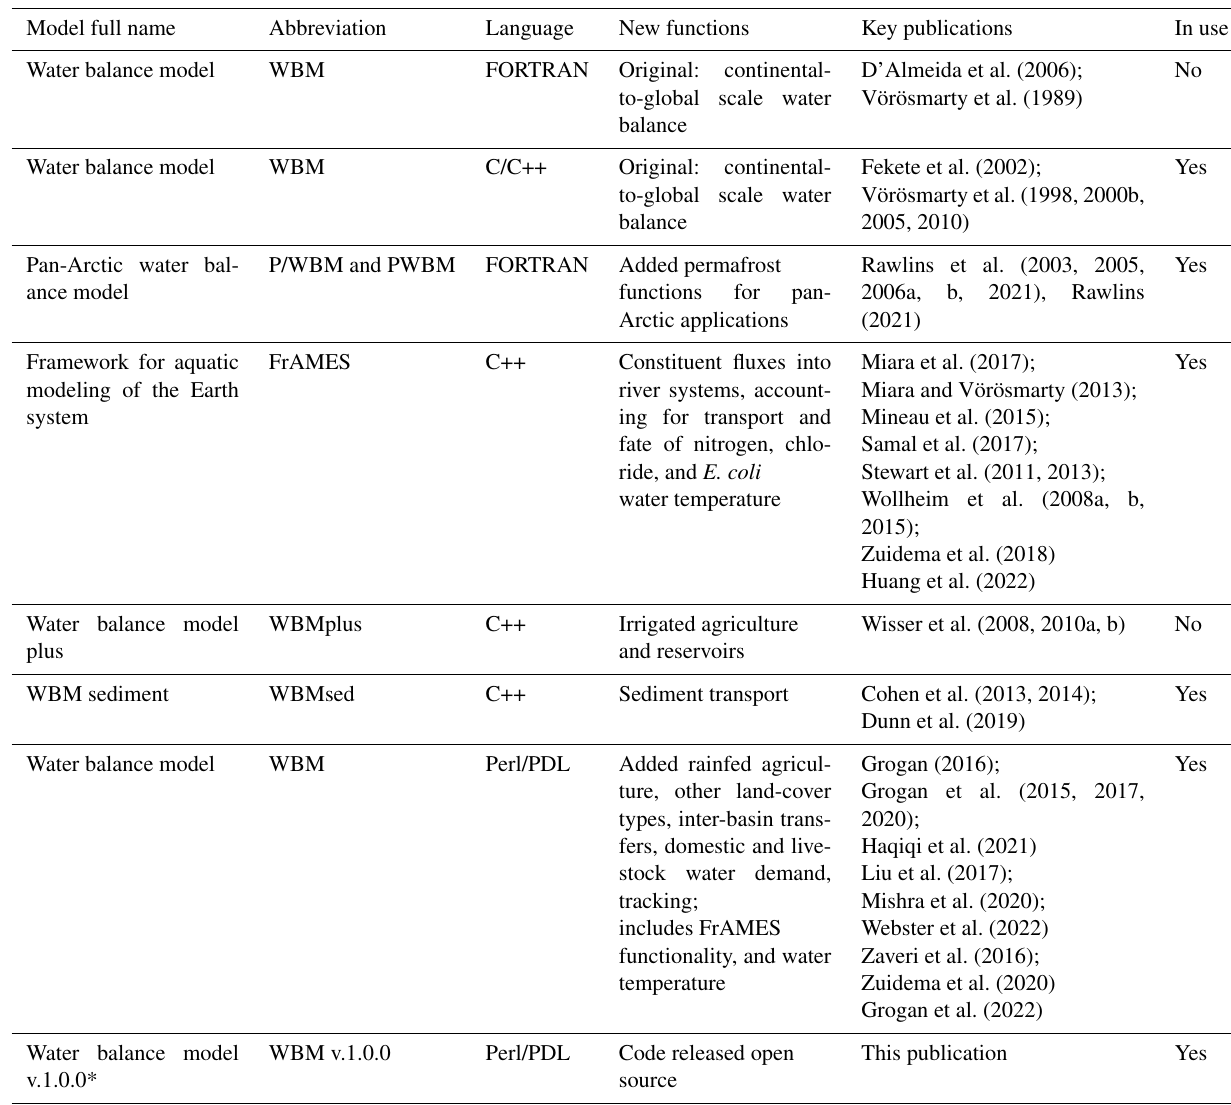
Table 7. Major WBM code branches, along with their history of new functionality and whether the code branch is still in